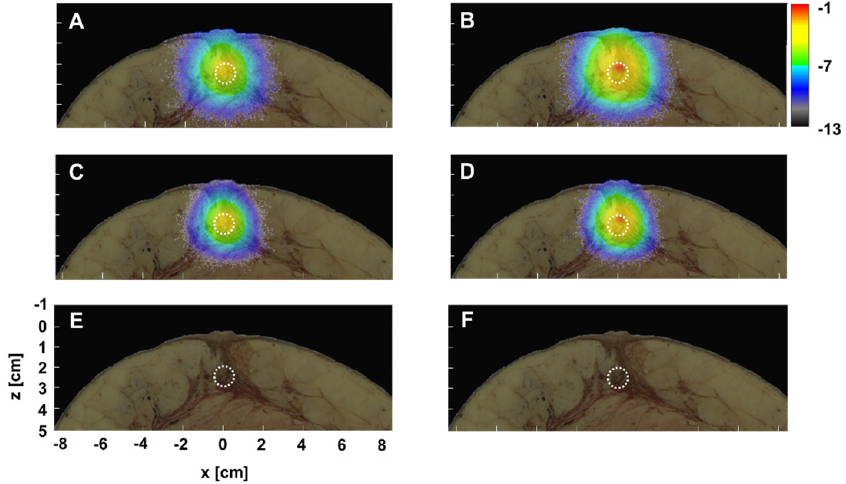
Figure 4. E ff ect of the excitation gradient in the SWIR ( A , B ), the NIR ( C , D ) and the VIS ( E , F ). Fluence maps without excitation gradient ( A , C , E ) and with gradient ( B , D , F ). Fluorescence-labeled cancer with a diameter of 1 cm in the duct were embedded x = 0 at a depth of 2 cm, denoted by circles of the white broken line. All maps share the values on the x and the z -axis of ( E ) and the scale bar, which shows the logarithmic scale of intensity (W / cm 2 ) in ( B ).